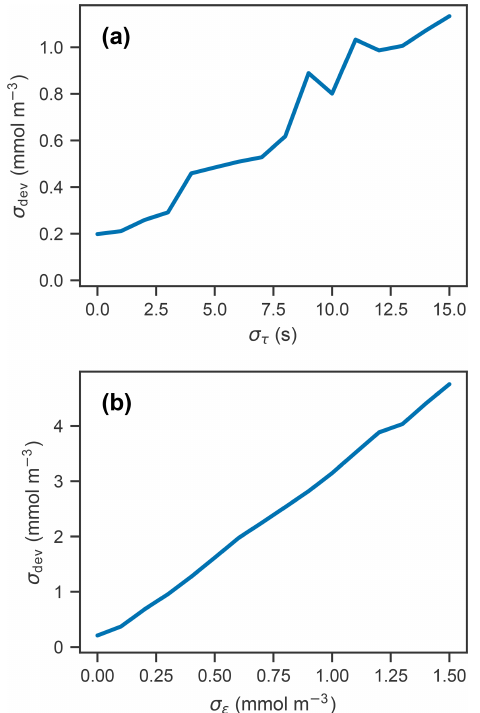
Figure 4. Standard deviation of the error profiles for increasingly wide distributions of (a) response time and (b) random error. For random errors, σ dev increases linearly with σ (cid:15) , with a slope of 3.09